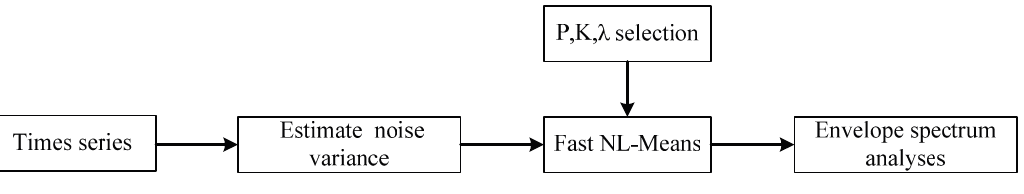
Figure 8. The scheme diagram of fast NL-Means and envelop spectrum.